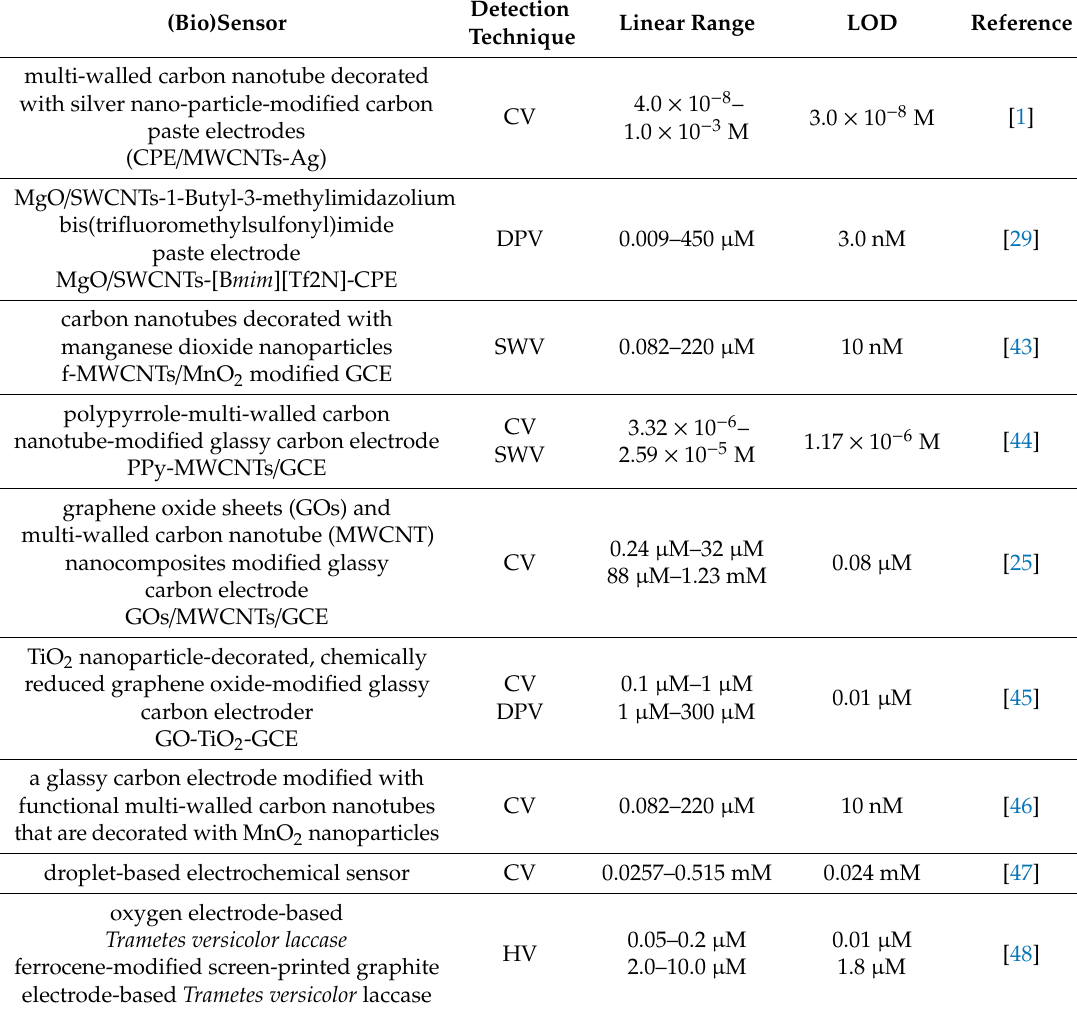
Table 1. Detection technique, linear range, sensitivity and limit of detection (LOD) of some voltammetric sensors and biosensors used for ferulic acid